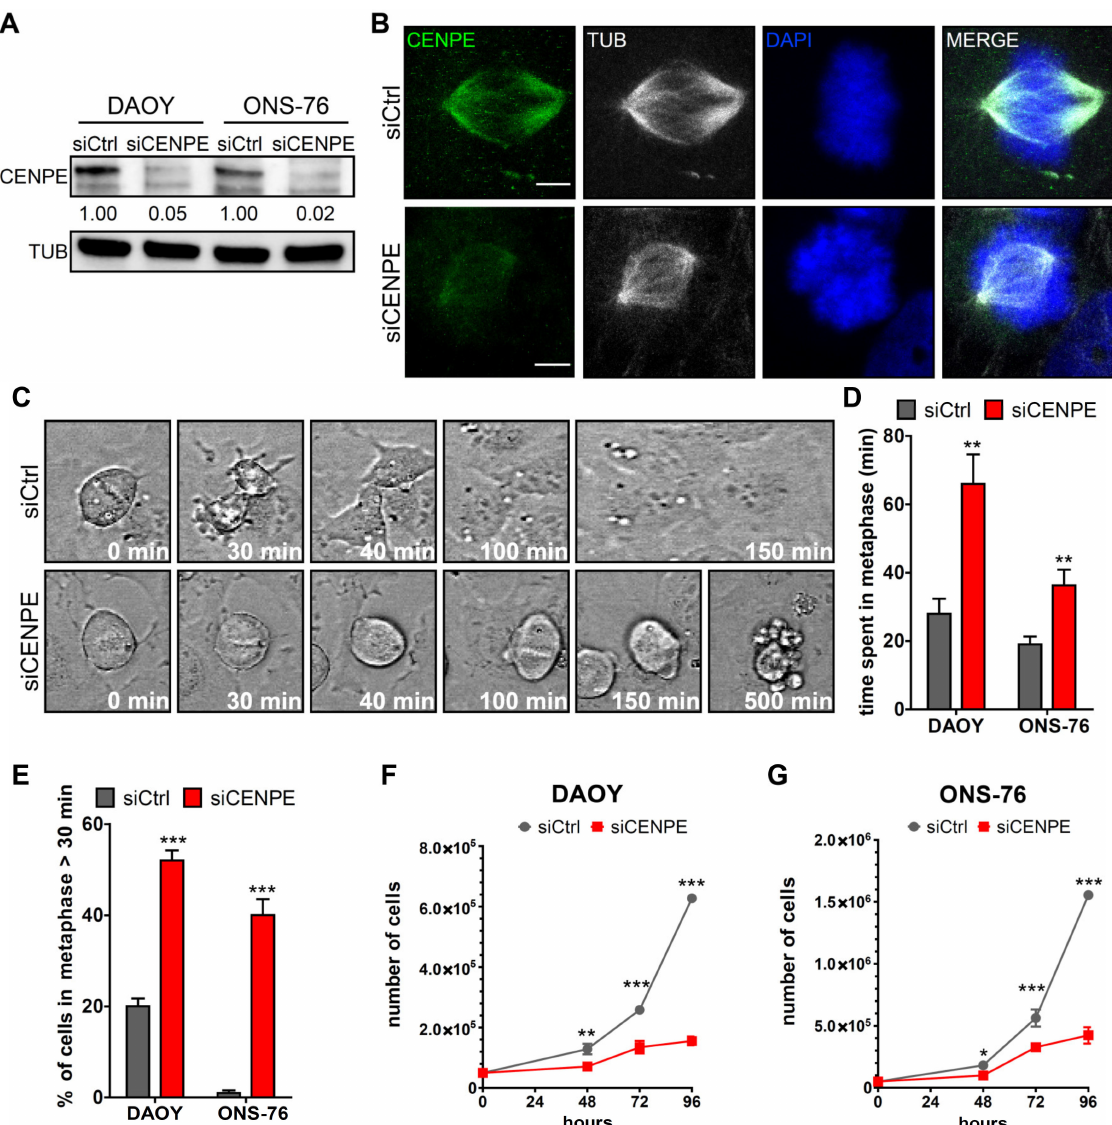
Figure 2. Medulloblastoma cells are sensitive to CENPE knockdown. ( A ) Western blot analysis of total lysate from DAOY and ONS-76 cell lines, 48 h after treatment with non-targeting (siCtrl) or CENPE-specific (siCENPE) siRNA. The level of CENPE was analyzed and the internal loading control was tubulin (TUB). The original images are shown in the Figures S1 and S2. ( B ) Representative image of DAOY cells processed for immunofluorescence 48 h after transfection with siCtrl or siCENPE and stained with anti-CENPE antibody, anti-Tubulin antibody and DAPI. ( C ) Representative images of live imaging performed on DAOY 30 h after transfection. Time lapses were recorded overnight with an interval of 5 min. Magnification: 40 × ( D ) Quantification of the time spent in metaphase by DAOY and ONS-76 cells analyzed as described in panel C. ( E ) Quantification of the percentage of cells showing metaphases lasting more than 30 min, in cells analyzed as described in panel C. Statistical test = Chi 2 , considering absolute number of cells in experiments. ( F , G ) DAOY and ONS-76 proliferation assay: 50,000 cells were transfected with non-targeting (siCtrl) or CENPE-specific (siCENPE) siRNA. Growth curves were obtained by assessing cells’ number in each well at 48, 72 and 96 h after transfection. Statistical test = two-tailed Student t -test. All quantifications were based on at least 3 independent biological replicates. At least 60 cell divisions were recorded for any biological replicate. Error bars, SEM. *, p < 0.05; **, p < 0.01; ***, p < 0.001. Scale bars, 5 µ